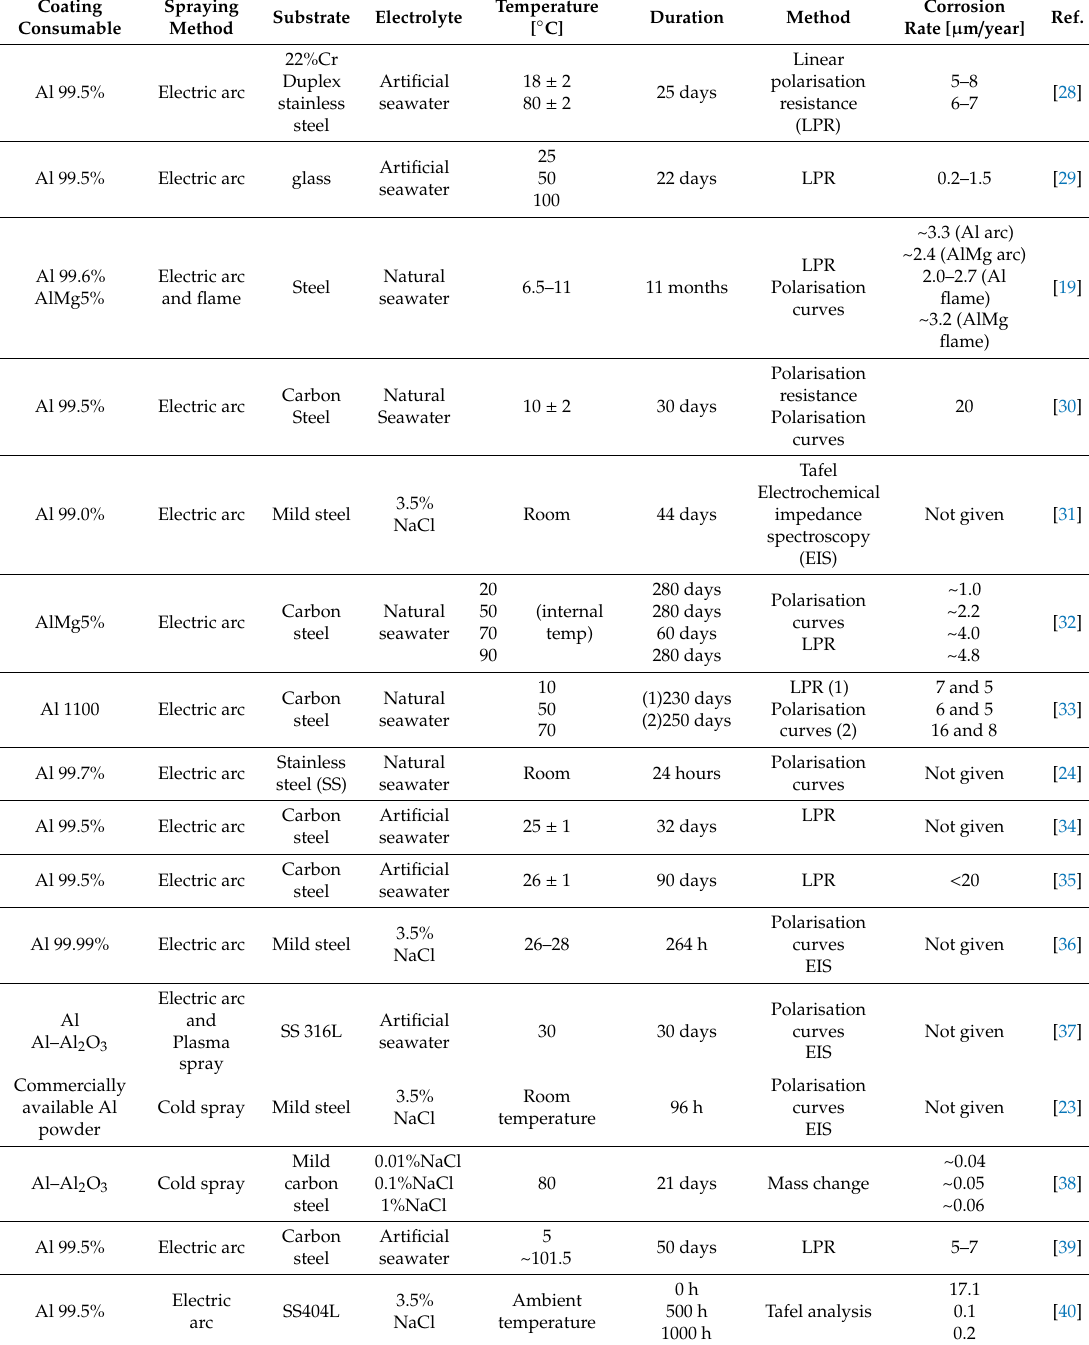
Table 2. Corrosion rates of Al-coatings in simulated or natural seawater